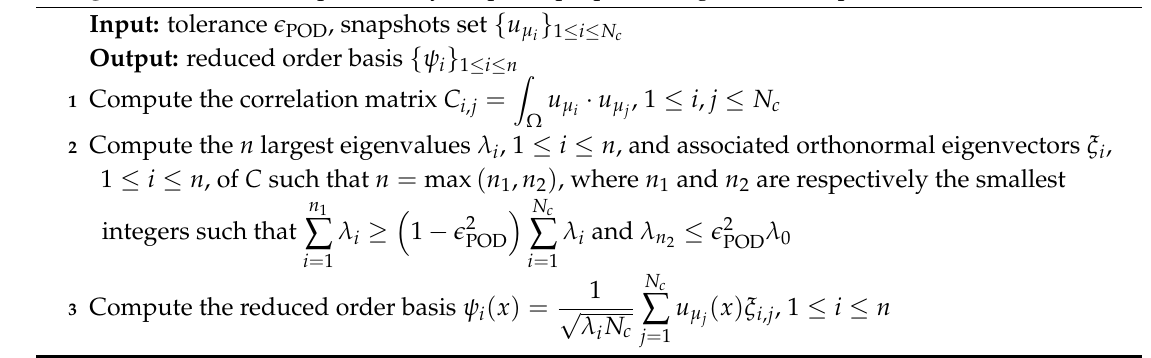
Algorithm 1: Data compression by snapshot proper orthogonal decomposition